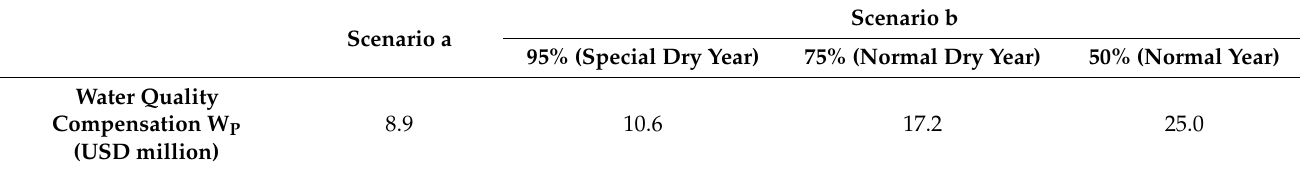
Table 5. The amount of ecological compensation based on the amount of pollutant reduction in different scenarios. Scenario a Water